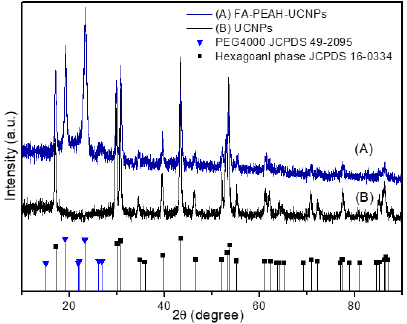
Figure 5. XRD patterns of (A) hexagonal-phase NaYF 4 :Yb/Er UCNPs, and (B) copolymer-modified hexagonal-phase NaYF 4 :Yb/Er UCNPs (FA-PEAH-UCNPs), bottom line patterns are the hexagonal-phase (JCPDS 16-0334) and PEG 4000 (JCPDS 49-2095).